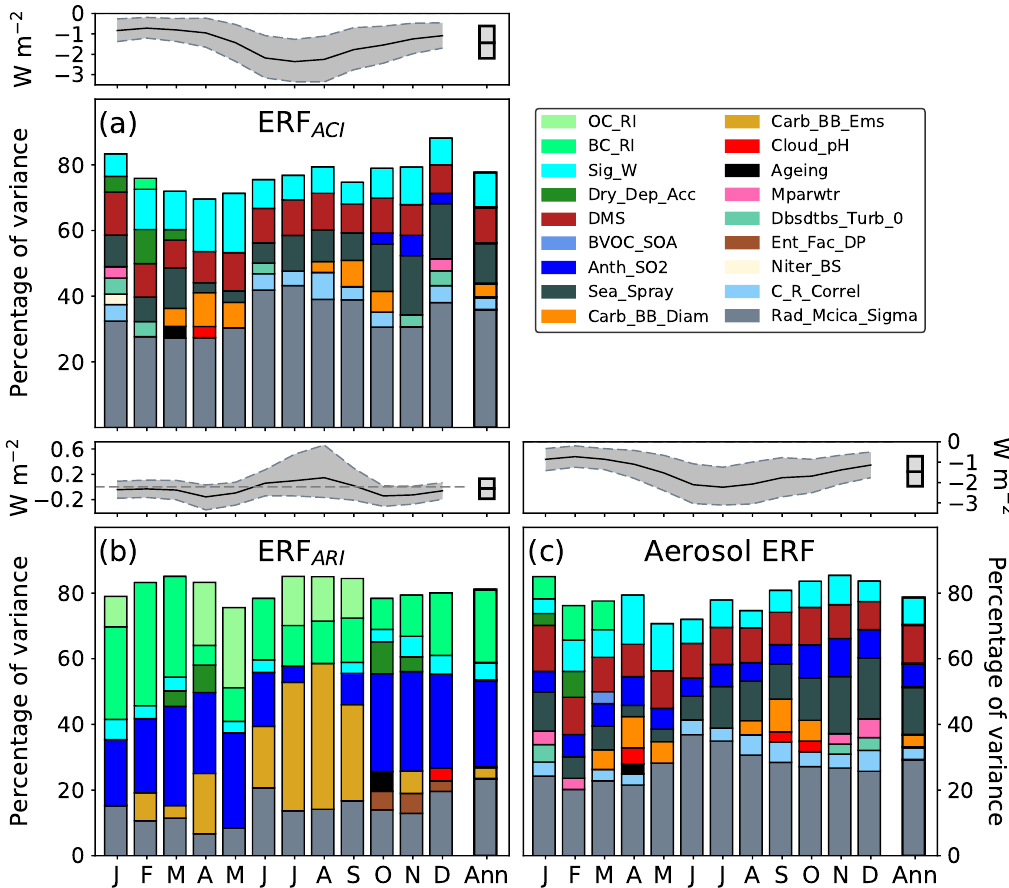
Figure 4. Percentage contributions to variance in global, monthly and annual mean 1850–2008 (a) ERF ACI , (b) ERF ARI and (c) aerosol ERF. Each bar contains only those parameters that cause at least 3% of the variance, and interactions between parameters are neglected. Therefore, the percentage of variance accounted for is less than 100%. The monthly and annual median values and 95% credible intervals (from the 270000 model variants) are displayed in the top panel. The monthly median values are connected in bold, and the credible intervals are shaded grey.